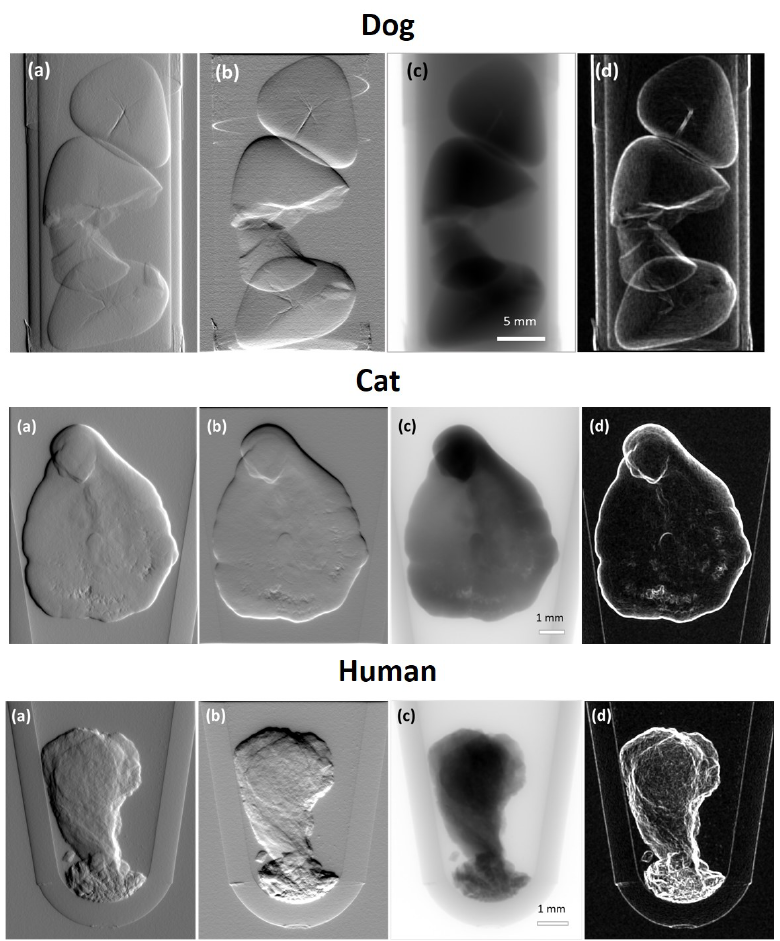
Figure 4. Multi-contrast radiographs extracted from dog, cat, and human urinary stones. ( a ) Hori- zontal refraction angle, ( b ) vertical refraction angle, ( c ) attenuation, and ( d ) dark-field